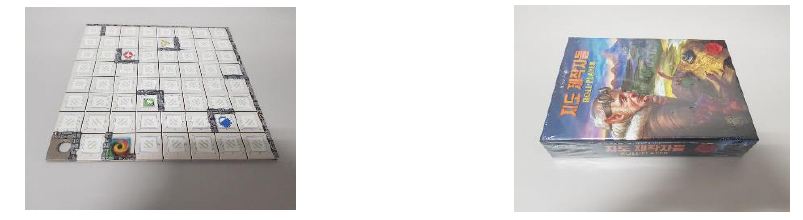
Figure 16. Photos and dimensions of the two items used for sensor characterization (unit: mm).